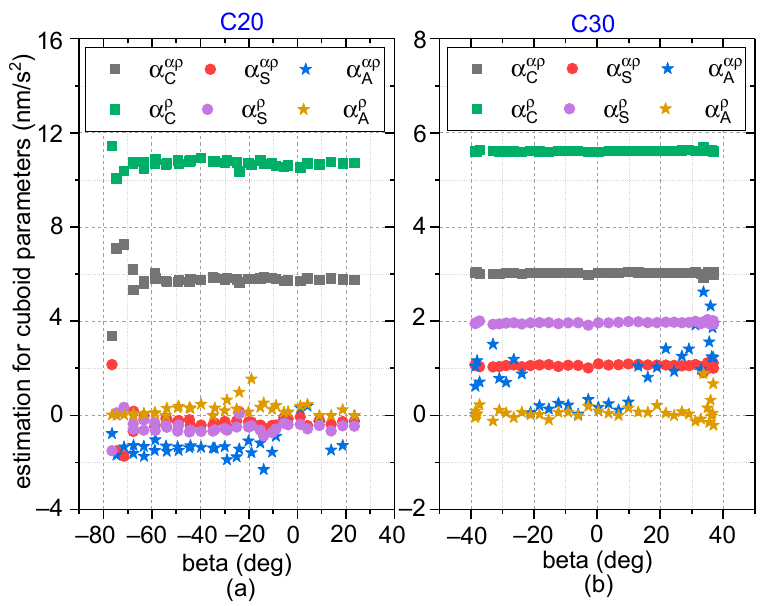
ρ and a , the red C C ρ and a . The left figures are for A A